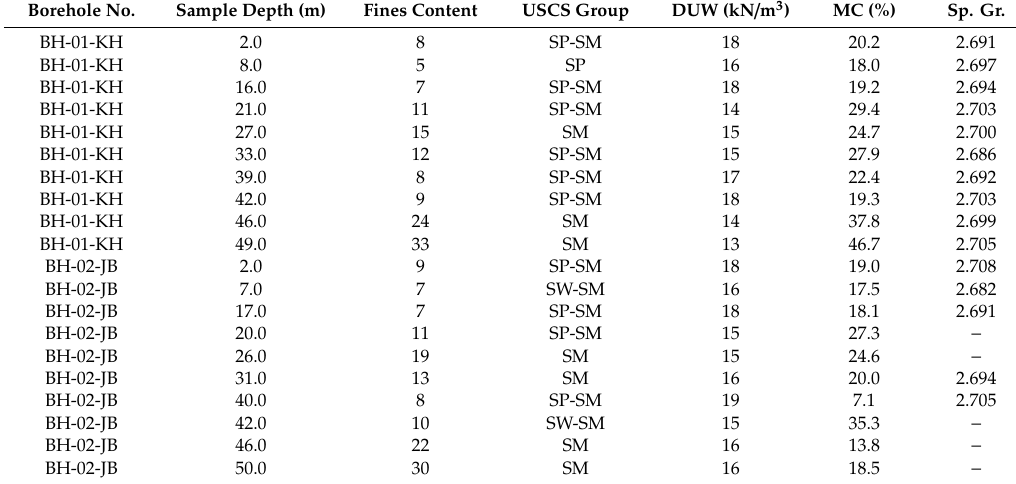
Table 4. Summary of soil sample test results from the Al-Khobar and Jubail sites. Borehole